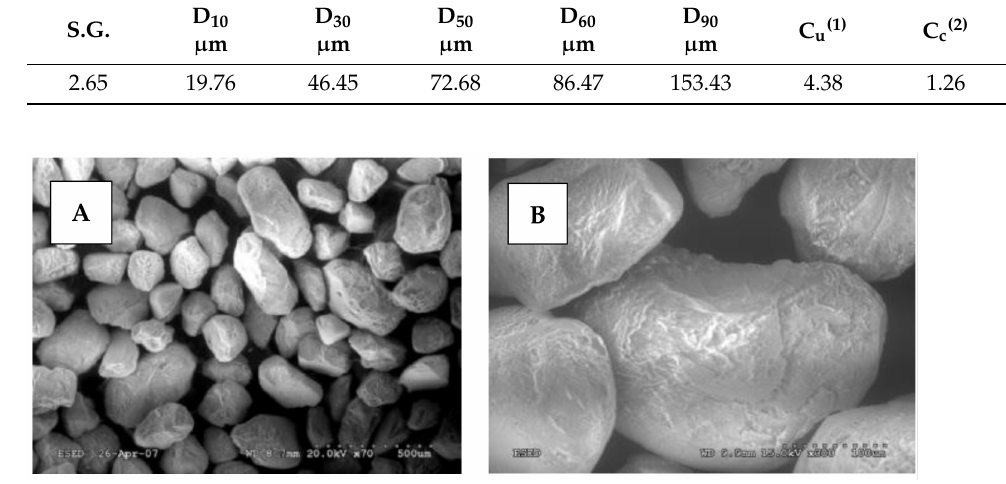
Figure 2. Scanning electron micrographs of silica sand at ( A ) 200 × and ( B ) 300 × magnification [36].